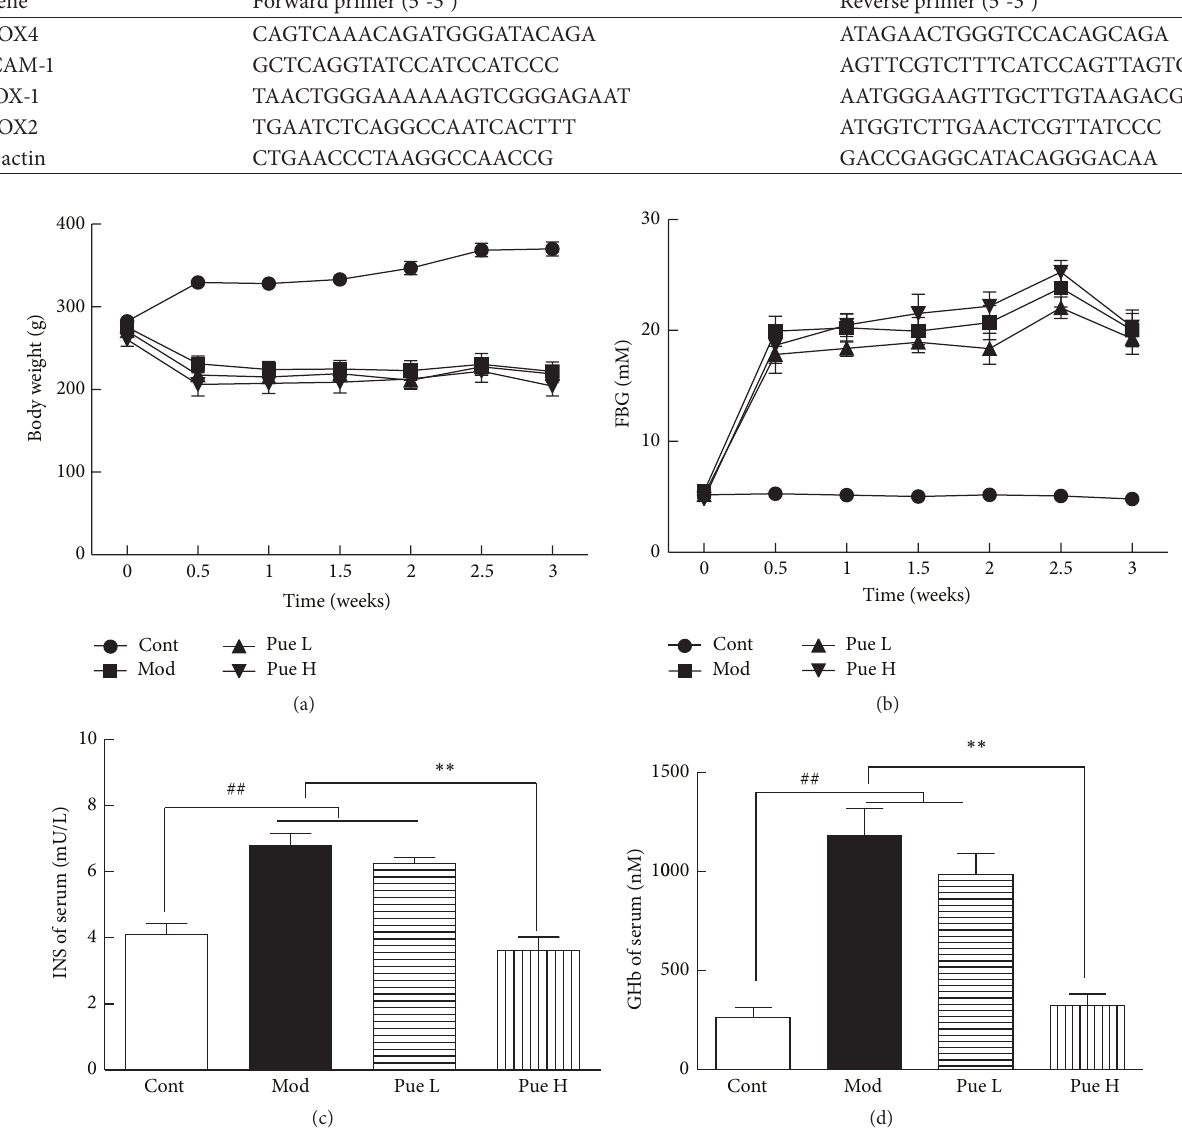
Figure 1: Effect of puerarin on body weight (a), FBG (b), serum INS (c), and GHb in STZ-induced diabetic rats. ## 𝑝 < 0.01 versus Cont; ∗∗ 𝑝 < 0.01 versus Mod. Cont, control group; Mod, diabetic model group; Pue L, low dosage of puerarin; Pue H, high dosage of